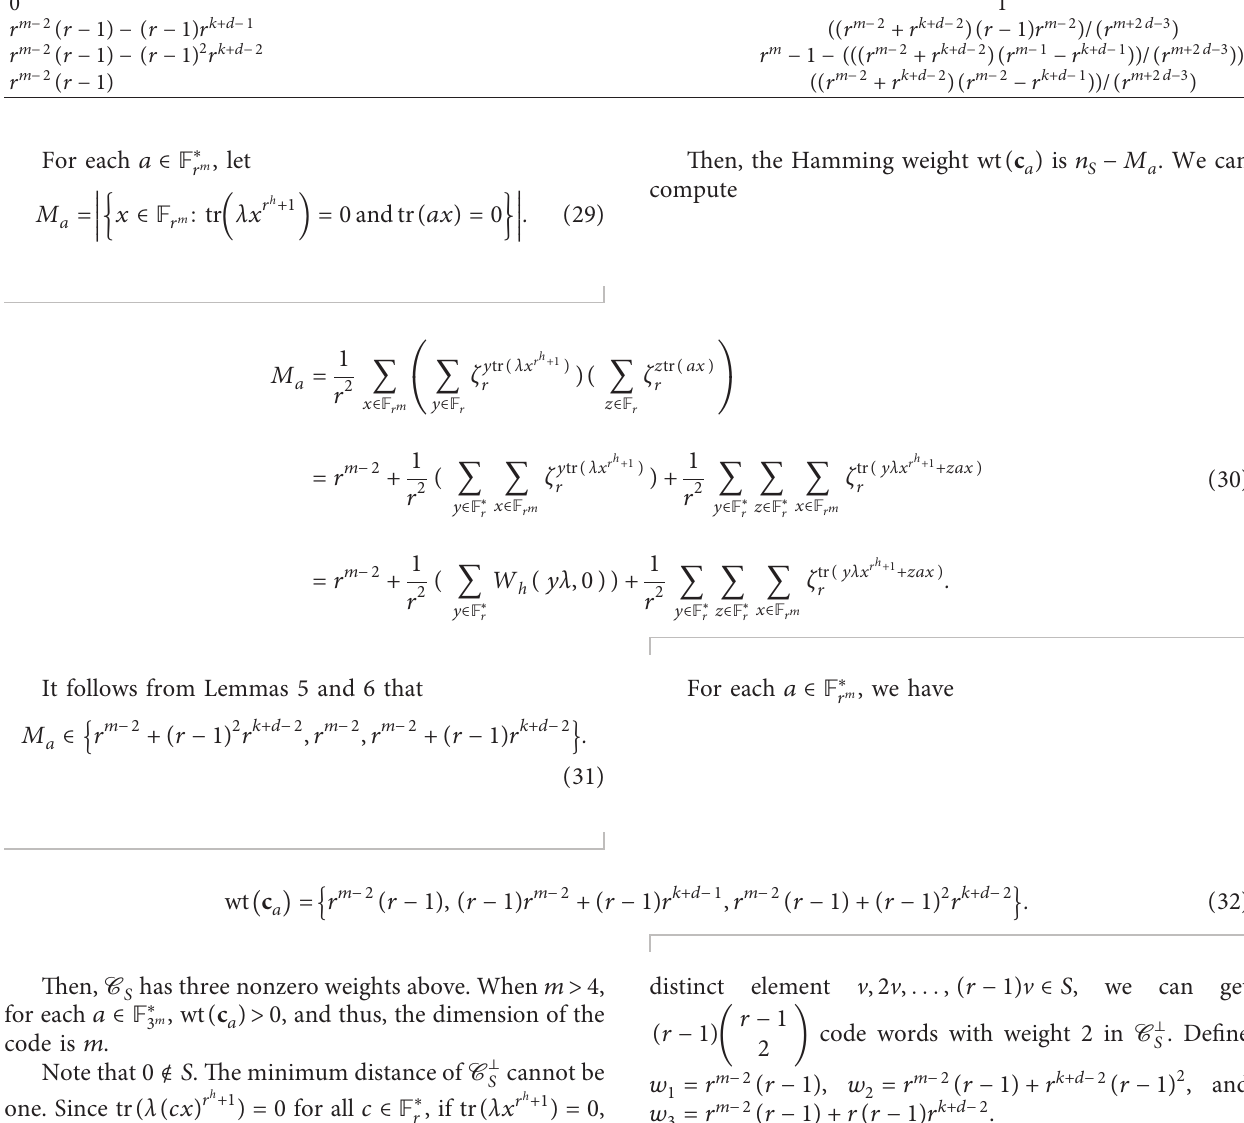
S for Theorem 3